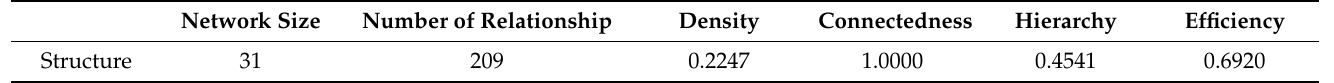
Figure 1. The structure of the network of health economy (2017). Table 1. The network structural characteristics of medical